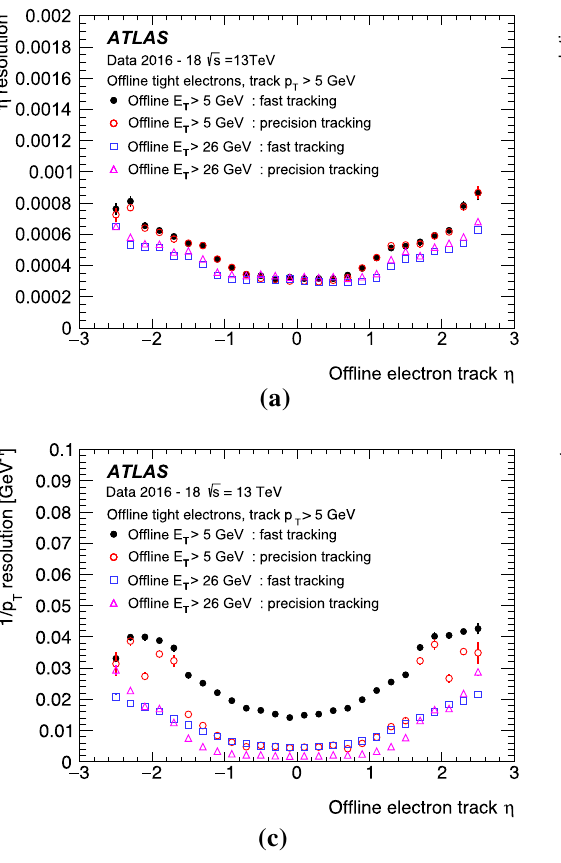
electrons selected by the 5GeV and 26GeV electron sup- port triggers for both the fast tracking and precision tracking